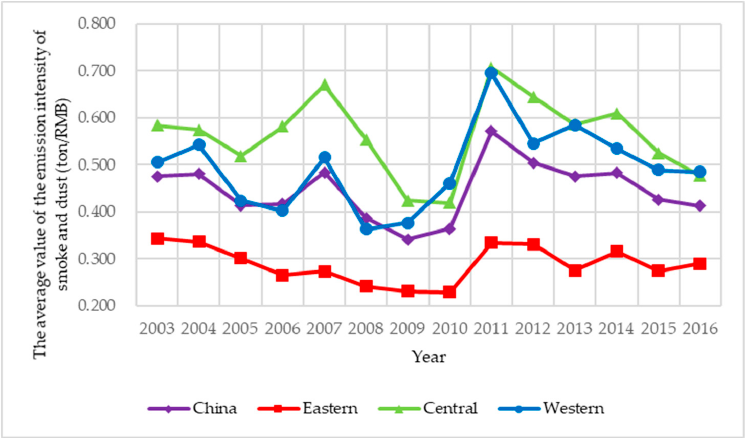
Figure 4. The average value of the emission intensity of smoke and dust in China during 2003–2016.